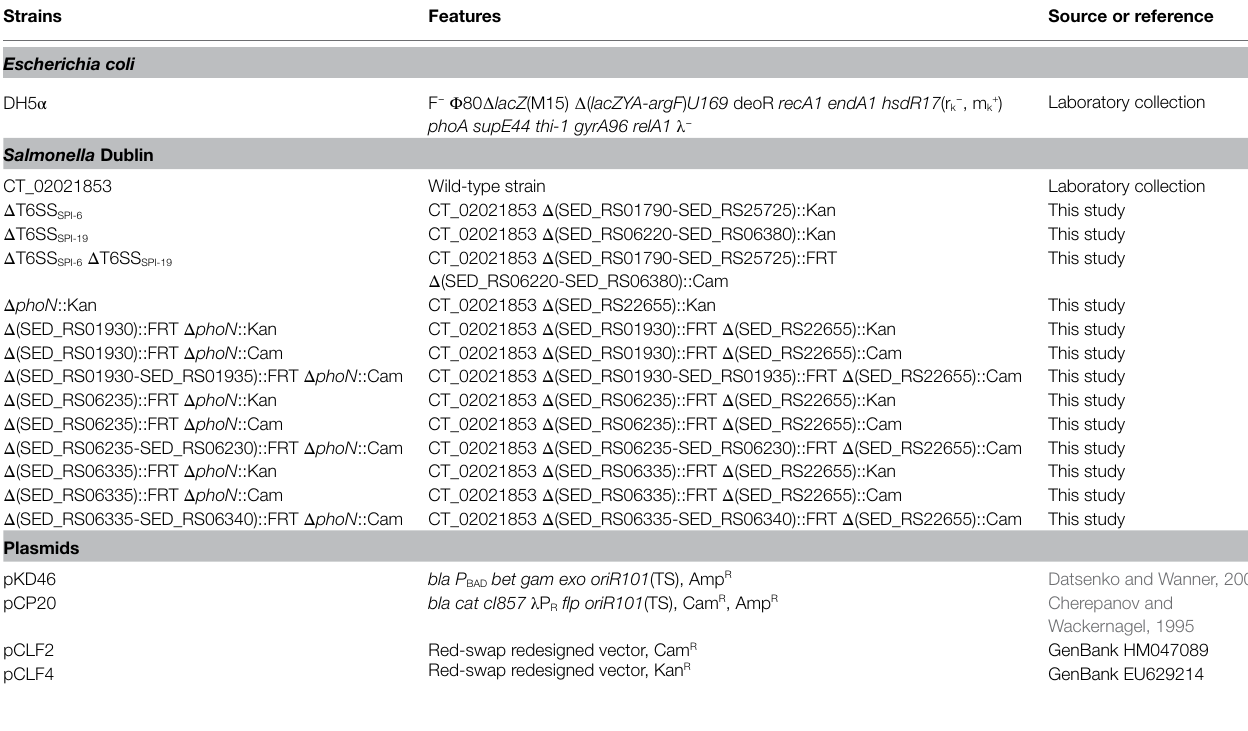
TABLE 1 | Bacterial strains and plasmids used in this study.